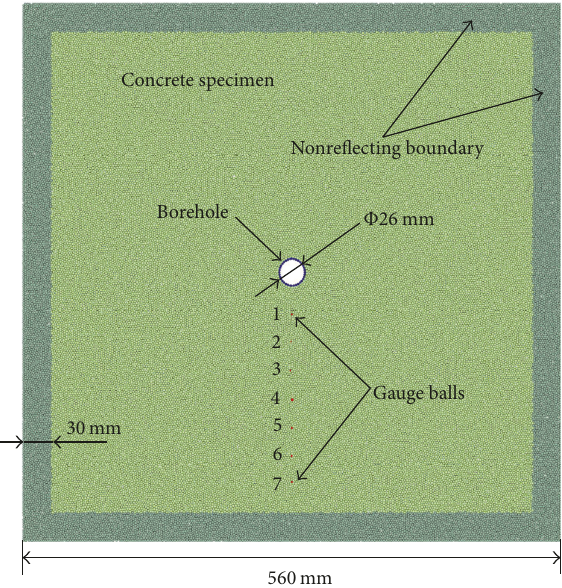
Figure 5: PFC fracturing model.